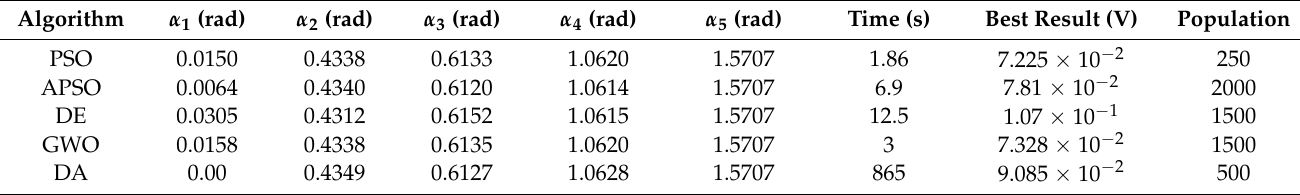
Table 6. Optimized switching angles for eleven-level CHB